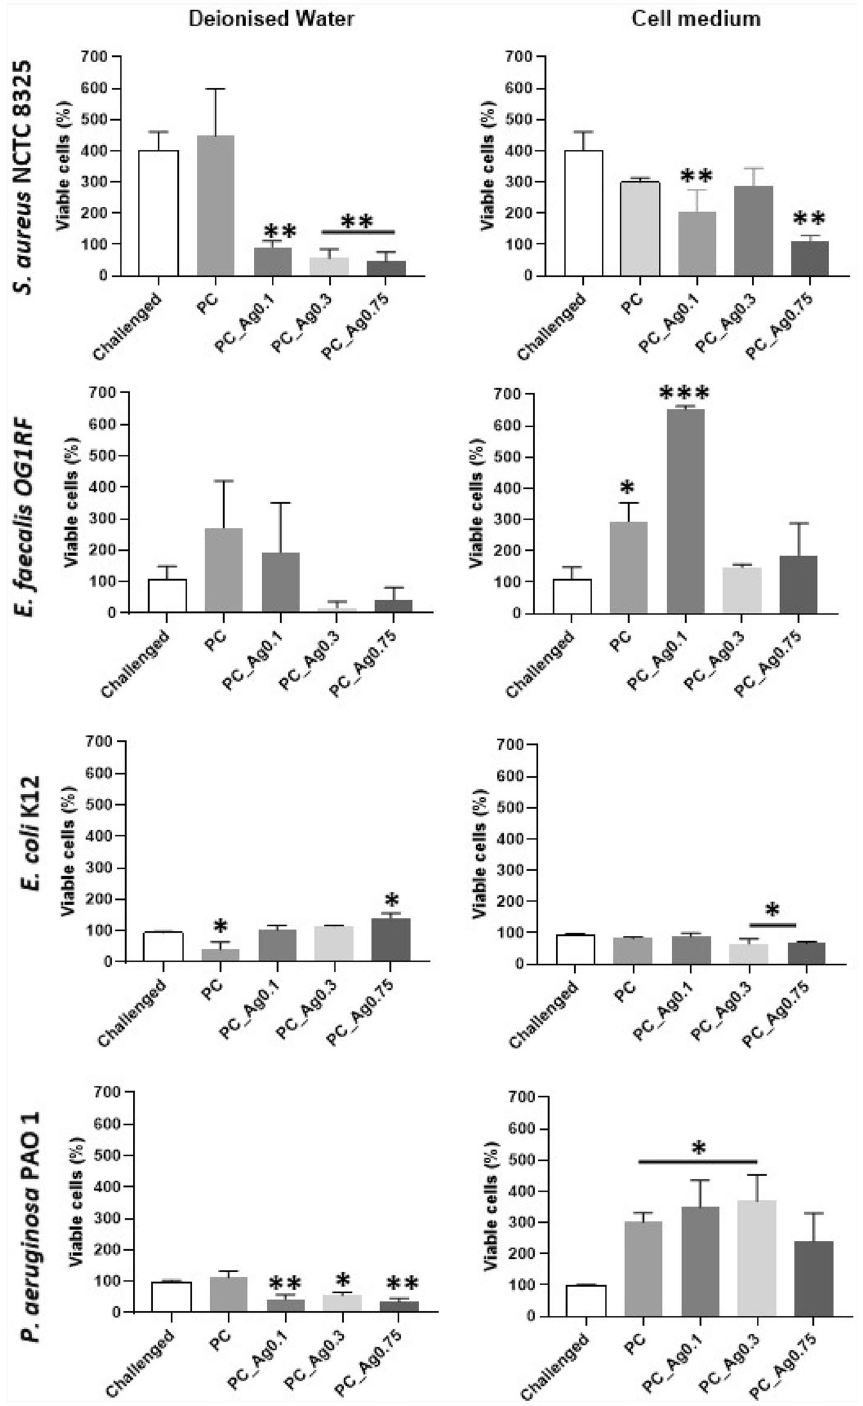
Figure 6. MTT analysis of HaCaT cells infected with bacteria in the presence of coacervate gels dissolution products in deionised water and cell medium. Error bars indicate the mean ± standard deviation. Statistical analysis was performed using one-way ANOVA (* p ≤ 0.05; ** p ≤ 0.01; *** p ≤ 0.001). Asterisks illustrate the degree of statistical difference when compared to the challenging